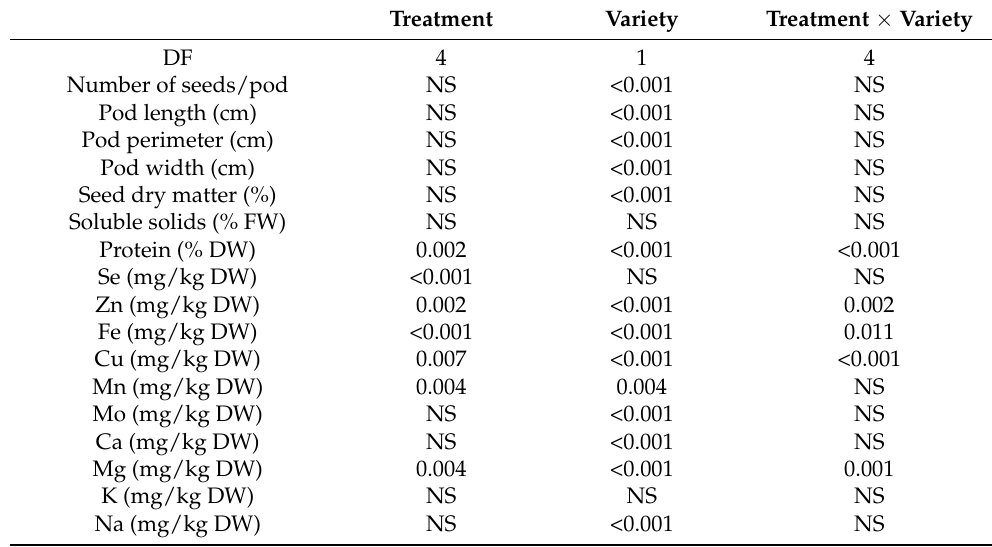
Table 2. Combined ANOVA for the effects of treatment and variety on number of seeds/pod, length, perimeter and width of the pod, seed dry matter, and levels of soluble solids, protein, Se, Zn, Fe, Cu, Mn, Mo, Ca, Mg, K, and Na in seeds. Treatment Variety Treatment × Variety DF